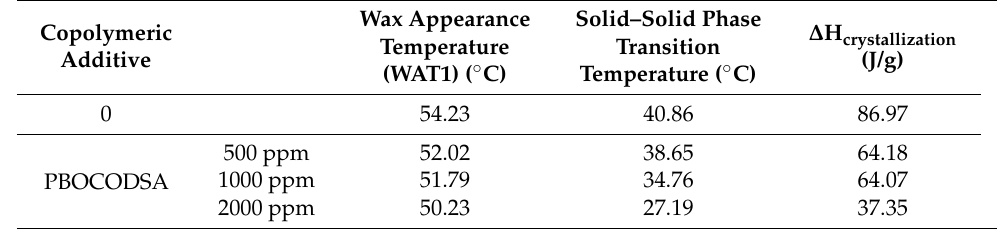
Figure 6. DSC thermographs of paraffin crystals in model waxy oil after 500, 1000, and 2000 ppm dosage of PBOCODSA during cooling at a rate of 10 °C/min. Table 4. T onset for crystallization of crude oil with and without improvers at a cooling rate of 10 ◦ C/min.